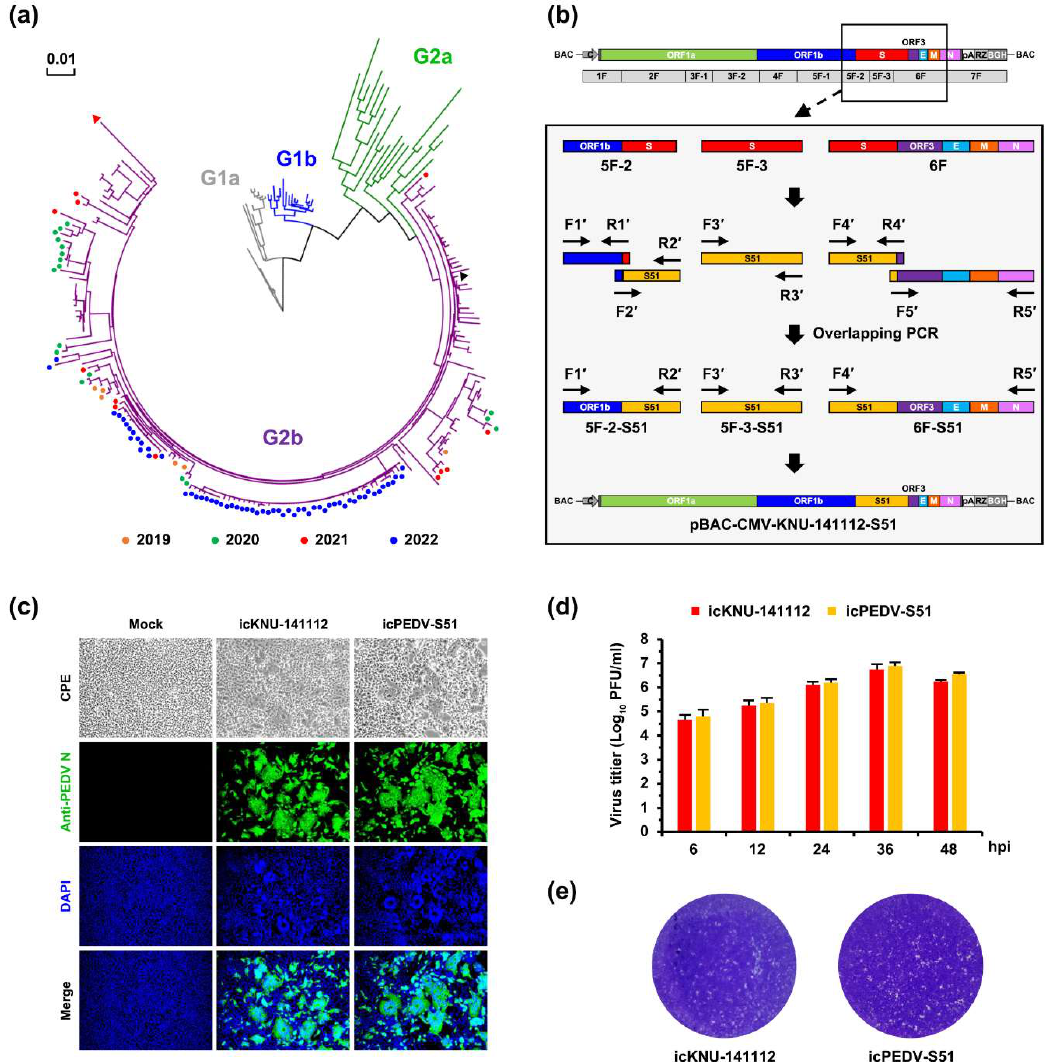
Figure 6. Construction and virological properties of recombinant icPEDV-S51. ( a ) Phylogenetic analysis based on the full S genes of the PEDV strains. Different colored dots indicate the PEDV strains chronologically identified in this study in 2019 (orange), 2020 (green), 2021 (red), and 2022 (blue). A red triangle indicates the VOI (GNU-2110) identified in this study, whereas a black triangle indicates the HP-G2b Korean prototype strain (KNU-141112). Four genotypes, G1a (gray), G1b (blue), G2a (green), and G2b (purple), are indicated. A scale bar indicates the number of nucleotide substitutions per site. ( b ) Strategy for constructing the recombinant molecular clone KNU-141112-S51 in BAC. The illustrations on top represent the genome organization of KNU-141112, which was divided into seven overlapping cDNA fragments (1F to 7F). Acronyms for viral genes and regulatory elements are described in Figure 1. The second diagram represents an enlarged version of the sub-fragments 5F-2 and 5F-3 and fragment 6F, spanning the full S gene, with different colored boxes indicating partial ORF1b (blue), S (red), ORF3 (purple), E (cyan), M (orange), and partial N (pink). Five amplicons covering 5F-2, 5F-3, and 6F, including S51 (yellow), are illustrated with different colored boxes, which were individually PCR amplified using respective primer sets (hypothetically named F1′-R1′ through F5′-R5′) indicated by arrows and then used as templates for overlapping PCR using primer sets (e.g., ‘F1′-R2′’ and ‘F4′-R5′’) to generate the 5F-2-S51, 5F-3-S51, and 6F-S51 (sub)fragments, respectively. These modified (sub)fragments were sequentially cloned into the plasmid pBAC-CMV-KNU-141112 to produce the recombinant infectious clone pBAC-CMV-KNU-141112-S51, as depicted at the bottom. ( c ) Phenotypic characteristics of icPEDV-S51. Vero cells were mock infected or infected with icKNU-141112 and icPEDV-S51 at an MOI of 0.1. PEDV-specific CPE was observed